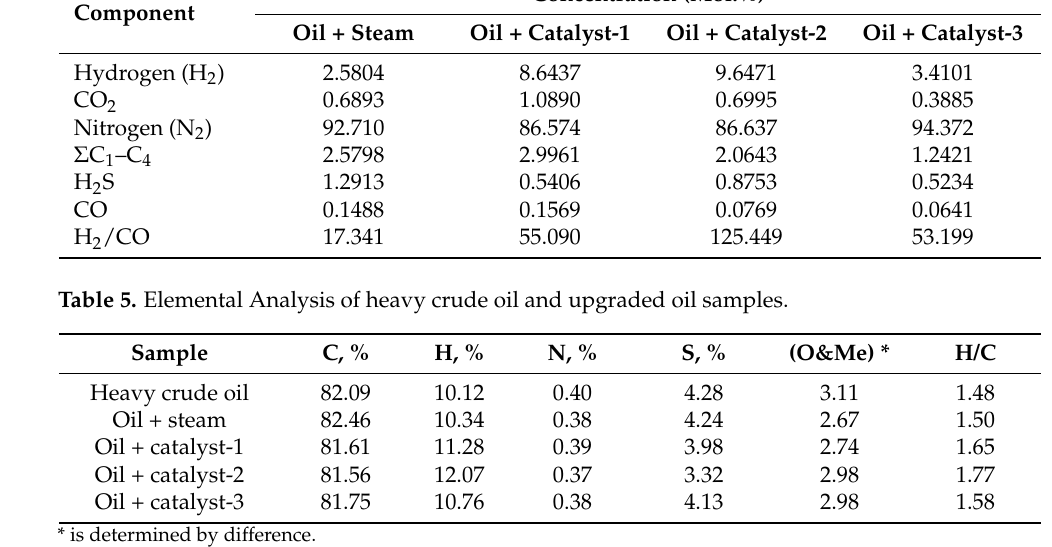
Table 4. Results of released gases analysis of the hydrothermal upgrading of heavy oil. Component